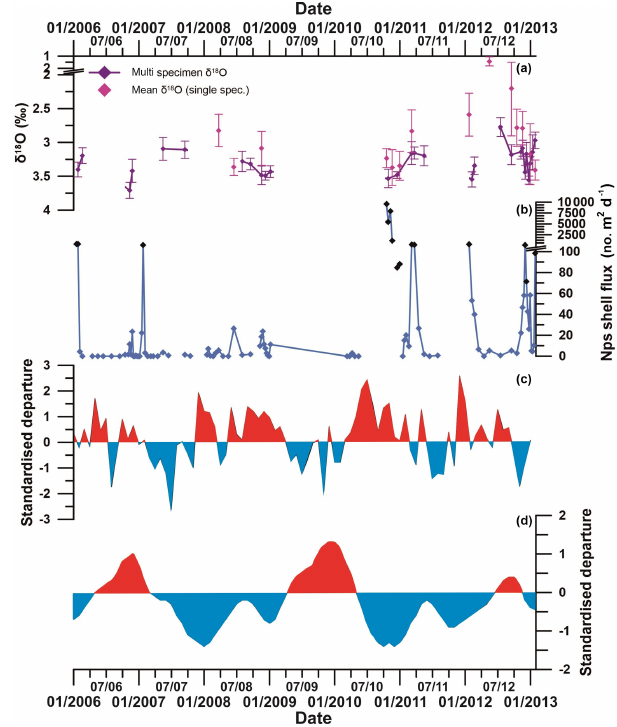
Figure 10. (a) Multi-specimen (purple) and single-specimen (pink) mean δ 18 O np (error bars show ± 1SD). (b) Total Nps flux (black di- amonds show statistically significant outliers, defined by interquar- tile range). (c) Southern Annular Mode (SAM) index and (d) El Niño–Southern Oscillation (ENSO) index. The SAM index is based on the departure from the zonal means between 40 and 65 ◦ S (Mar- shall, 2003). Red sections show positive SAM, and blue sections show negative SAM. The ENSO index is based on the departure from the 1950–1993 reference period (Wolter and Timlin, 2011). Red sections show El Niño-like conditions, and blue sections show La Niña-like conditions. Note the co-variation between positive SAM and La Niña-like conditions; negative SAM and El Niño-like conditions; and the strong positive SAM, La Niña and high Nps flux in